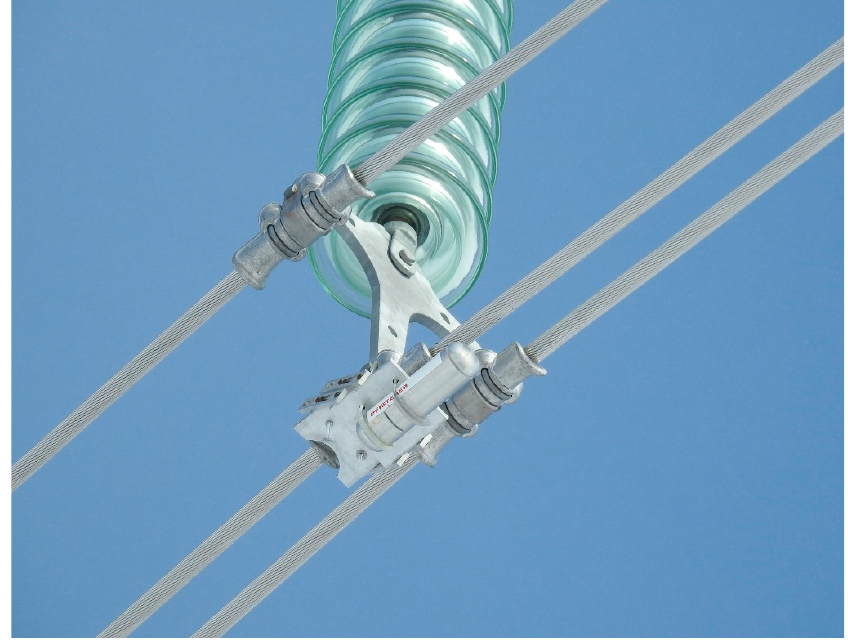
Figure 3. Vibration recorder mounted at the suspension clamp.